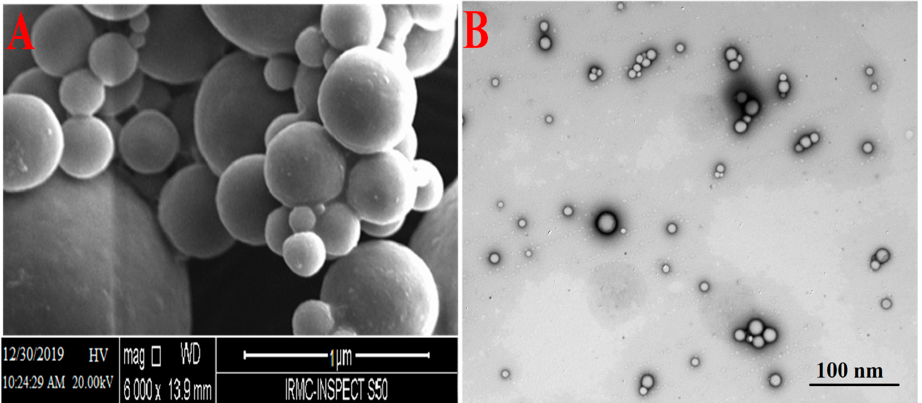
Figure 5. Scanning electron microscopy (SEM) ( A ) and transmission electron microscopy (TEM) ( B ) images of CS-coated–CH-loaded–PLGA–NPs.